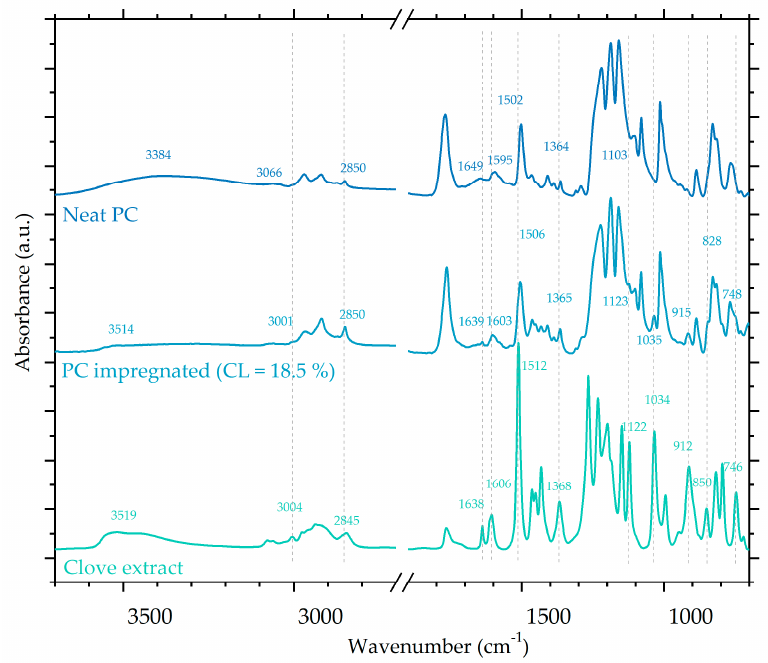
Figure 8. ATR—FTIR spectra of crude clove extract, neat PC, and PC impregnated with clove extract at 60 °C and 10 MPa with CL = 18.5%.